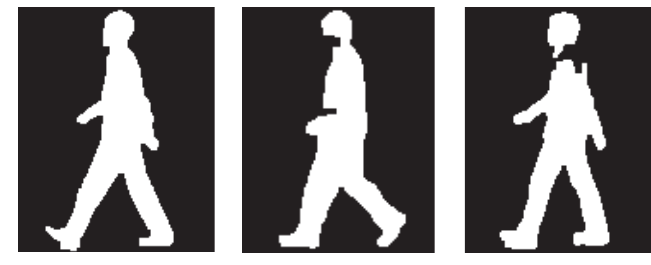
Figure 4. Examples of silhouette images of the CASIA-B